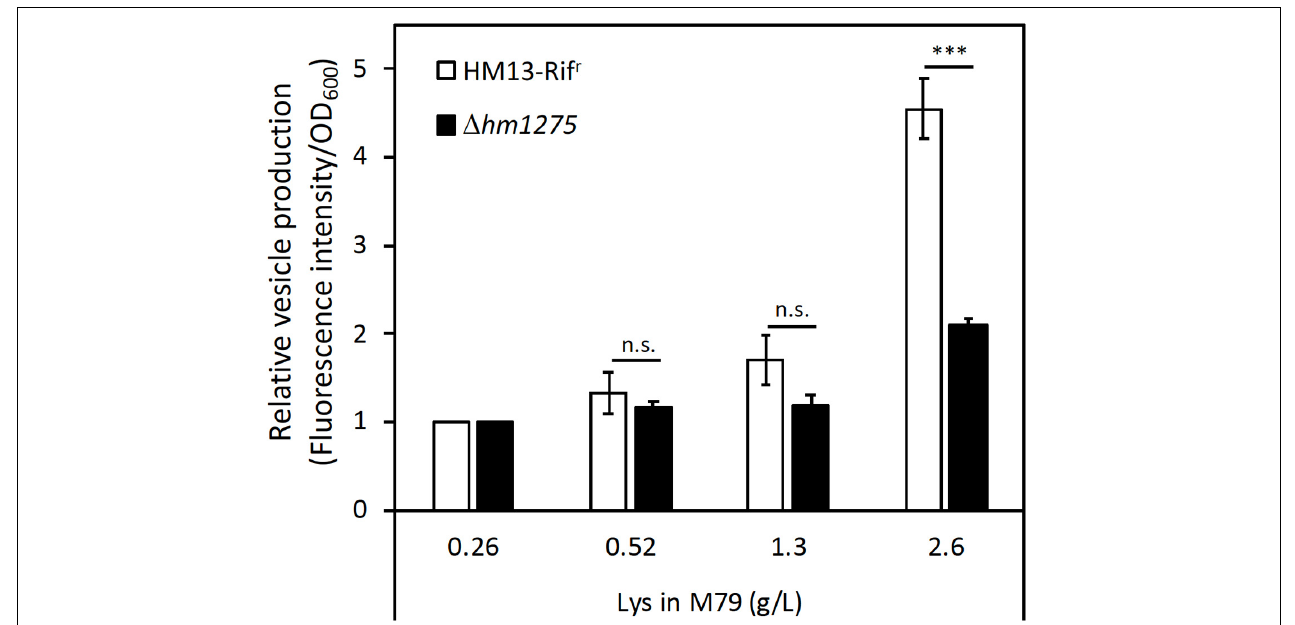
FIGURE 3 | Induced vesicle production of S. vesiculosa HM13 by the addition of Lys in a concentration-dependent manner. The vesicle production of HM13-Rif r and (cid:49) hm1275 cultured at different Lys concentrations was quantified by lipid staining. Each value of vesicle production was divided by that of cells grown in M79 containing 0.26 g/L Lys to compare relative vesicle production in each condition. The data are the means ± relative standard errors of the values from three independent batches. Statistical analysis was performed using two-tailed unpaired Student’s t -test. n.s. and ∗∗∗ indicate p ≥ 0.1 and p < 0.01, respectively.